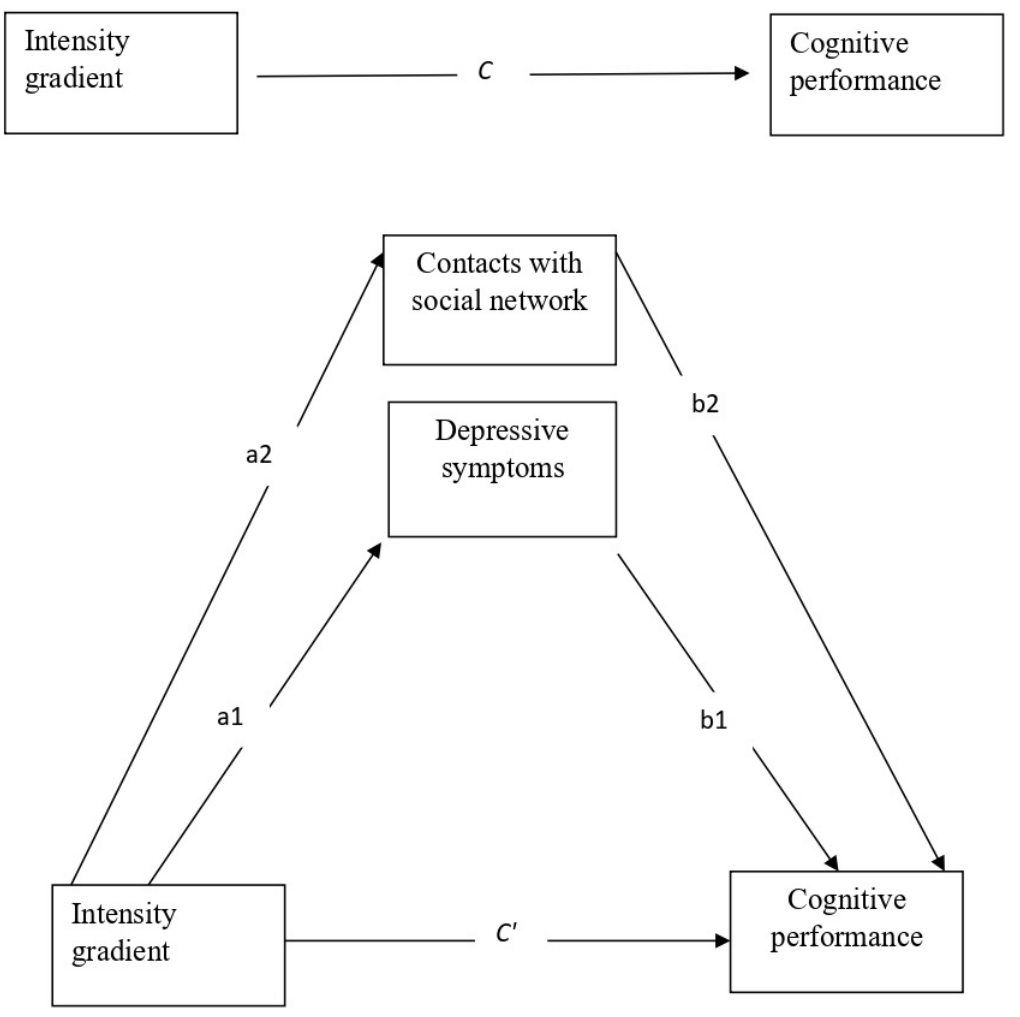
Figure 1. The main study model—a multiple mediator model depicting the direct effect without mediators (weight C ) and with mediators (weight C ′ ); and the indirect effects (sum of all a × b weights) of the intensity gradient via the two mediators (contact with the social network and depressive symptoms), controlling for the covariates.